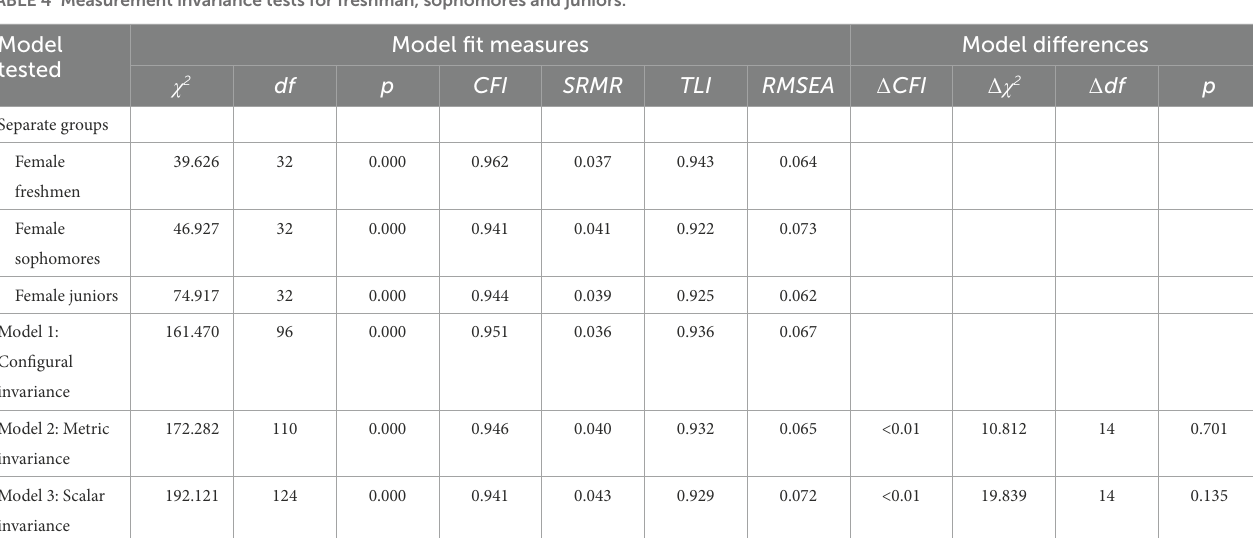
TABLE 4 Measurement invariance tests for freshman, sophomores and juniors.